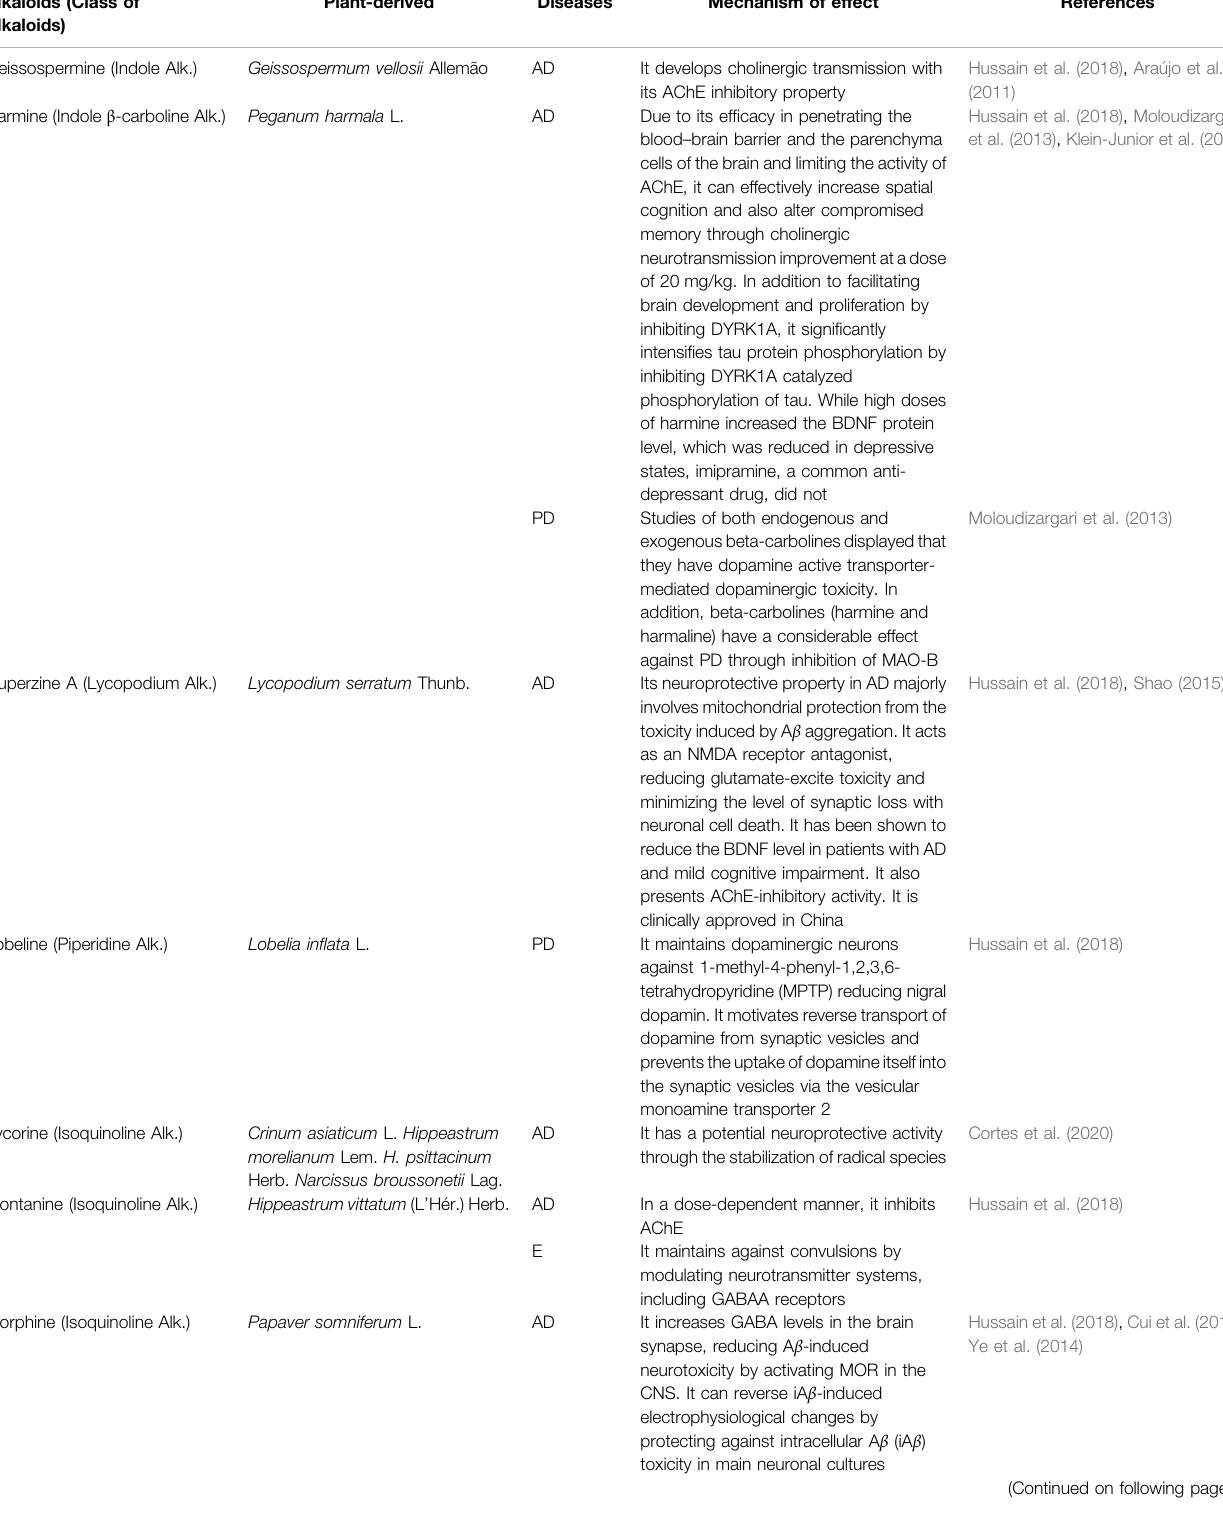
TABLE 1 | ( Continued ) Alkaloids, their sources, target neurodegenerative diseases and their mechanism of